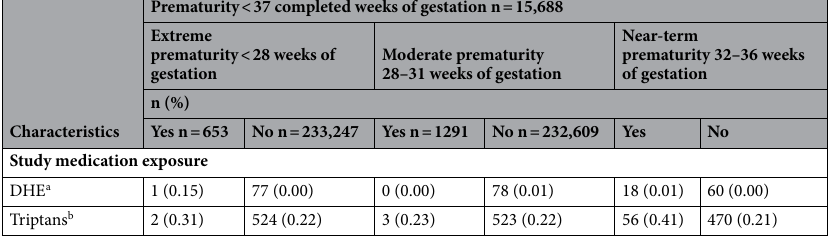
Table 2. Study medication exposure during pregnancy and the risk of prematurity by sub-categories of prematurity. a Dihydroergotamine; b Including almotriptan, eletriptan, naratriptan, rizatriptan, sumatriptan, and